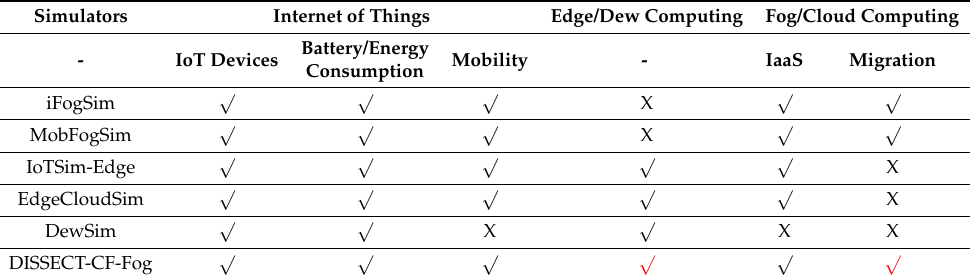
√ means the simulator contains that